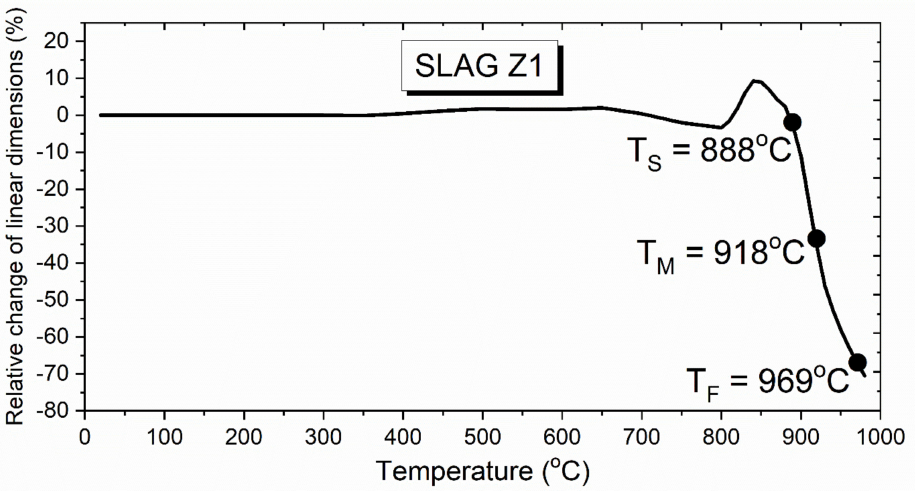
Figure 3. Results of hot-stage microscopy test of test slag; T S -sintering temperature, T M -melting temperature, T F -flow temperature